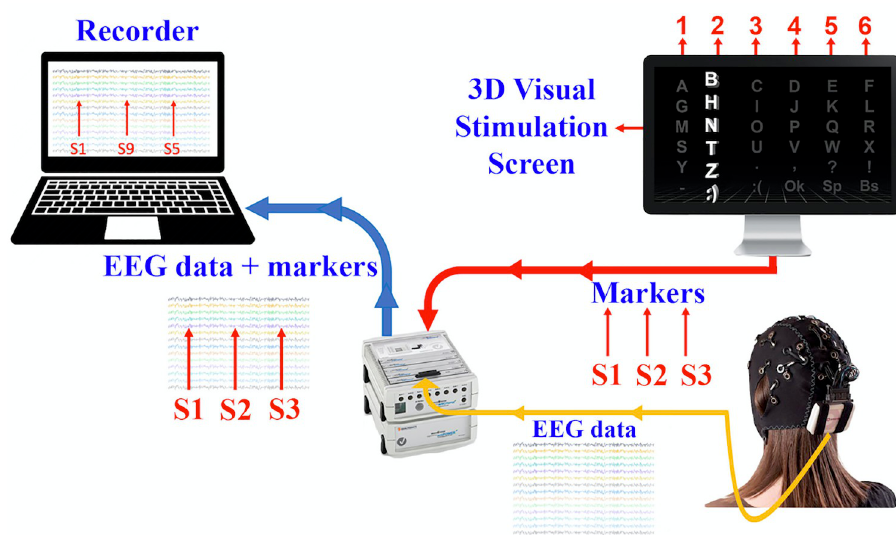
Fig 7. EEG data and procedure for recording